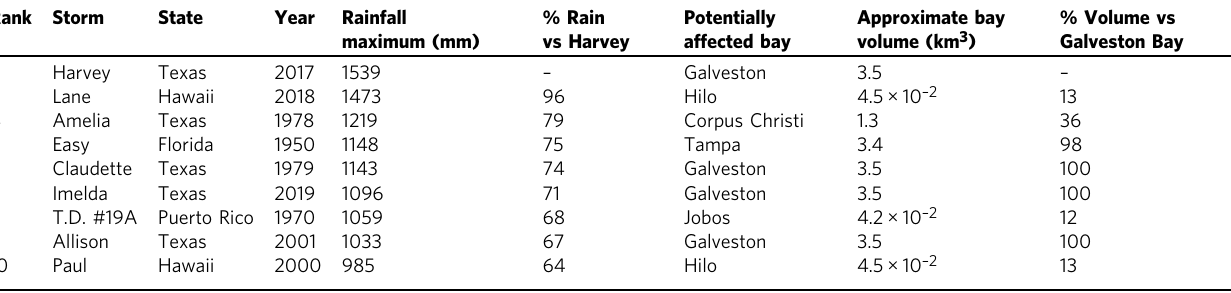
Table 2 Rainfall record of top ten wettest tropical cyclones in US history and site of nearby enclosed bay or estuary system. Rank